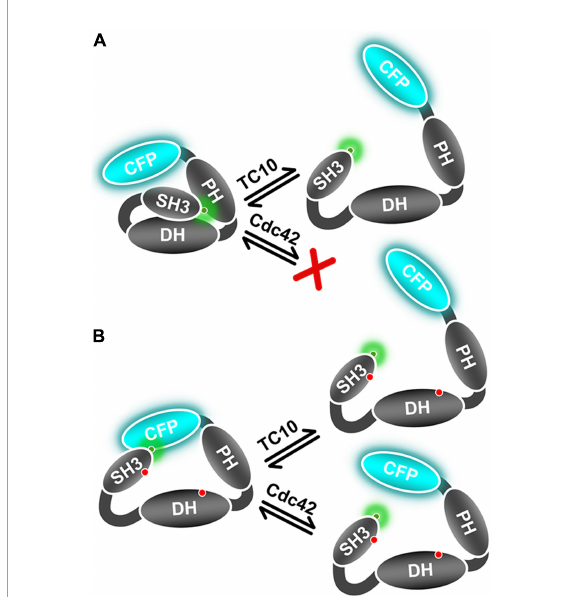
FIGURE7 Schematic representation of TC10 and Cdc42 mediated CB conformational activation. (A) This panel represents the wild-type mimicking CB FRET sensor (F1 DA ) in the auto-inhibited form and its conformational state after interaction with TC10 or the inability of Cdc42 to interact with this sensor. (B) Cartoon depicting the active state CB FRET sensor (F1 dmDA ) conformational change after TC10 and Cdc42 binding. TC10 binding induces a strong change in (cid:104) τ (cid:105) and hence a large inter-fluorophore movement, whereas it is relatively small for Cdc42. Red dots on the SH3 and DH domain represent the incorporated amino-acid replacements in the F1 dmDA construct.